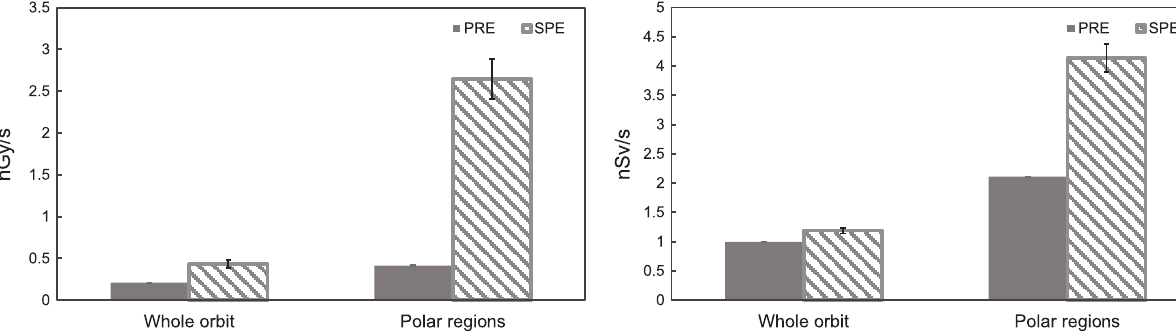
Fig. 11. Time averaged dose (left panel) and dose equivalent (right panel) during the SPE and during the quiet Sun period (PRE). The error bars represent statistical errors.